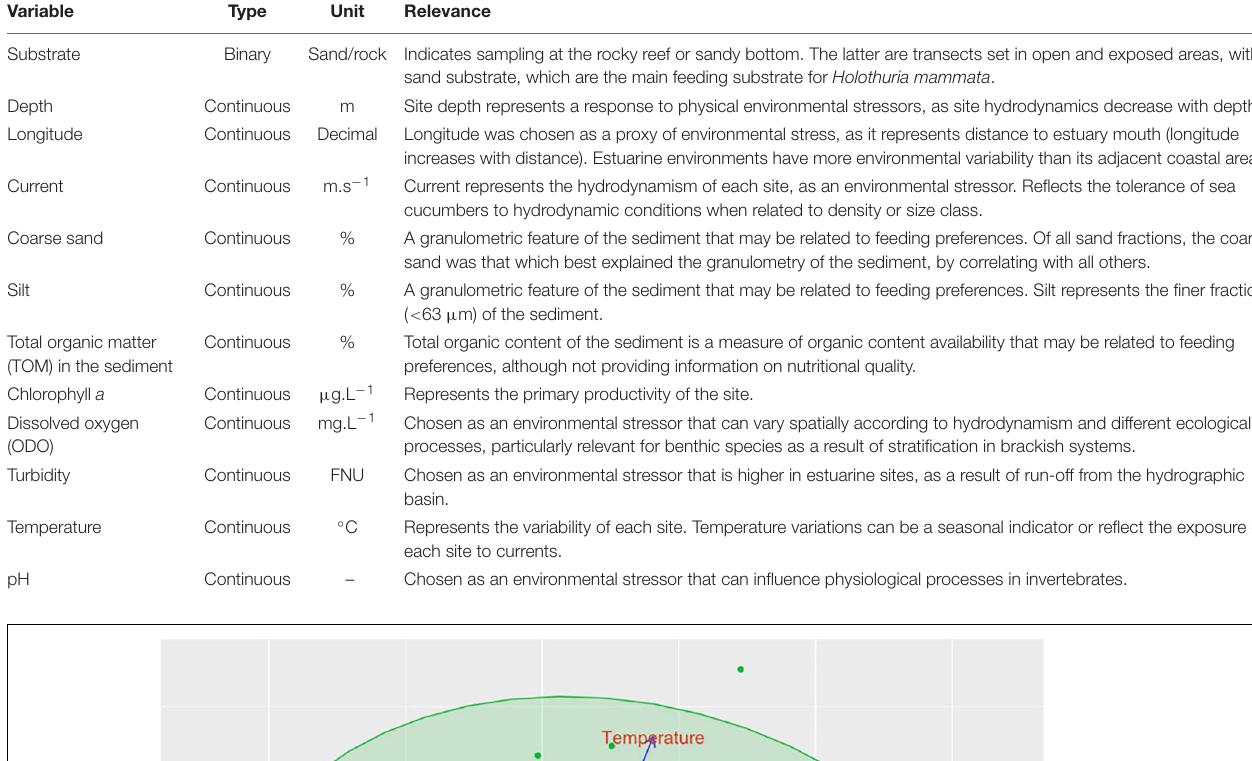
TABLE 1 | Selected variables based on variance inflation factors to be included in empirical models assessing habitat preferences for Holothuria mammata . Variable Type Unit Relevance